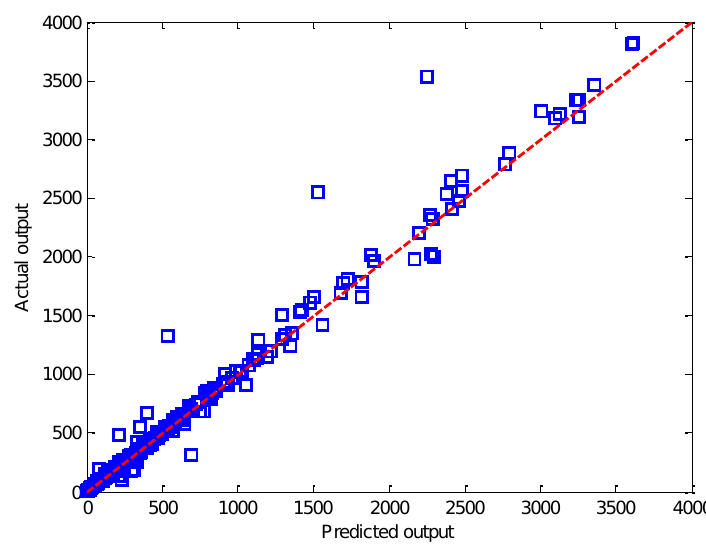
Figure 4. Performance of the committee neural network (CNN) for prediction.